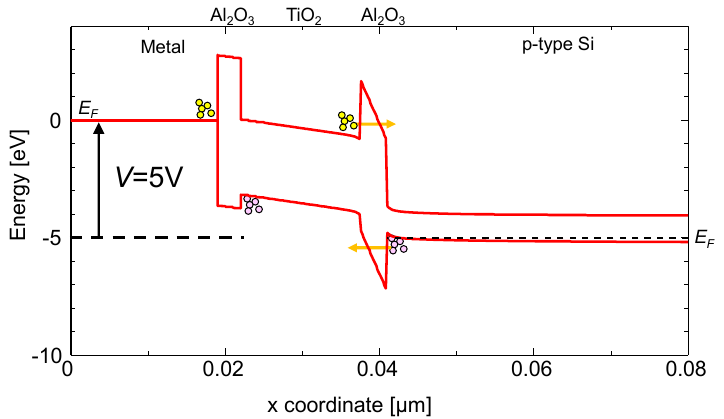
Figure 8. Calculated MOS band diagram at V = − 5 V. These simulation results were obtained using the TCAD software Silvaco Atlas. The work function of Al electrode was assumed at 4.20 eV. The electron affinities of Al 2 O 3 and TiO 2 were taken to be 1.4 [43] and 4.0 eV [44], respectively. The bandgaps of Al 2 O 3 and TiO 2 were taken to be 6.4 [43] and 3.2 eV [45], respectively.